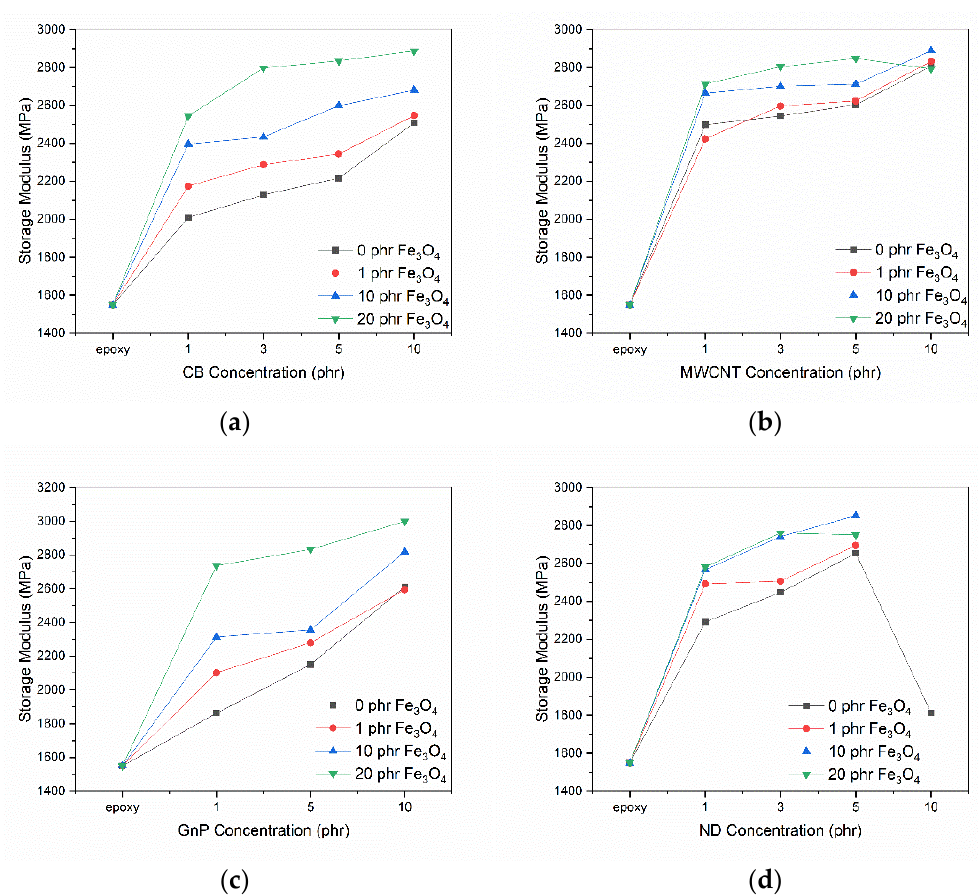
Figure 4. Storage modulus as a function of ( a ) CB; ( b ) MWCNT; ( c ) GnP; ( d ) ND concentration for all examined systems.